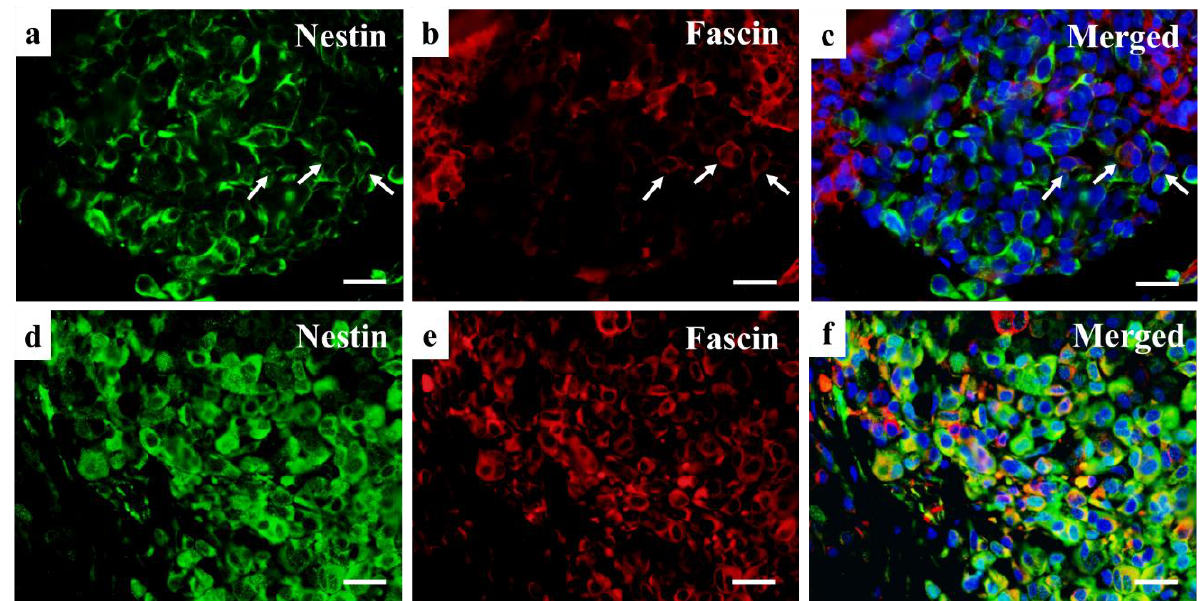
Figure 7. Immunofluorescence staining of Nestin, Fascin, and the merged staining of the two proteins in the primary tumor ( a – c ) and metastasis ( d – f ) of Case 28. An 88-year-old man was diagnosed with melanoma on the volar aspect of the toe and received amputation in May 2016. No further treatment occurred for the patient and in April 2017, he developed distant metastasis. Allred scores of Nestin and Fascin were +8 and +4 at the primary tumor, and +8 and +8 at metastasis, respectively. At the primary tumor ( a – c ), Nestin positive cells are observed in the large area of the tumor, and Fascin is partially positive in the tumor. Nestin and Fascin double-positive cells (arrows) are also observed sporadically in the tumor tissue. At the metastasis ( d – f ), both Nestin and Fascin are strongly positive. (Scale bars: 50 μ m)